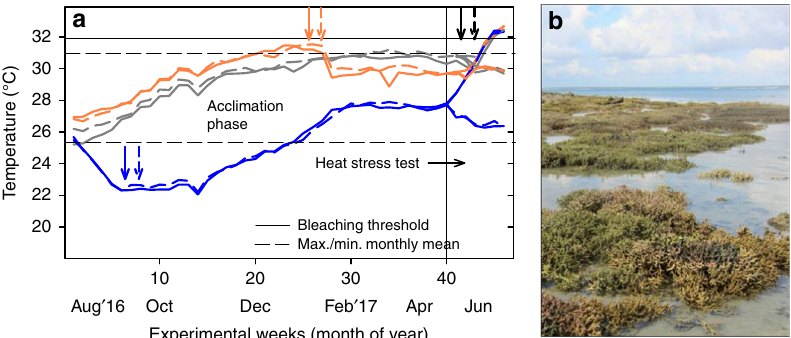
Fig. 1 Temperature regimes during the long-term acclimation phase and subsequent heat stress test. a Weekly average temperatures of corals maintained at three different temperature regimes and exposed to either constant daily temperature (solid coloured lines) or 4 °C daily temperature variability (dashed coloured lines). For the heat stress test, all treatments were split into ambient control and heated tanks. Coloured arrows indicate when paling/bleaching was observed for the respective treatments. Black arrows represent bleaching in all treatments. b Naturally stress-resistant coral communities from the macrotidal Kimberley region exposed during spring low tide. Source data are provided in the Source Data and Supplementary Data 1 fi les